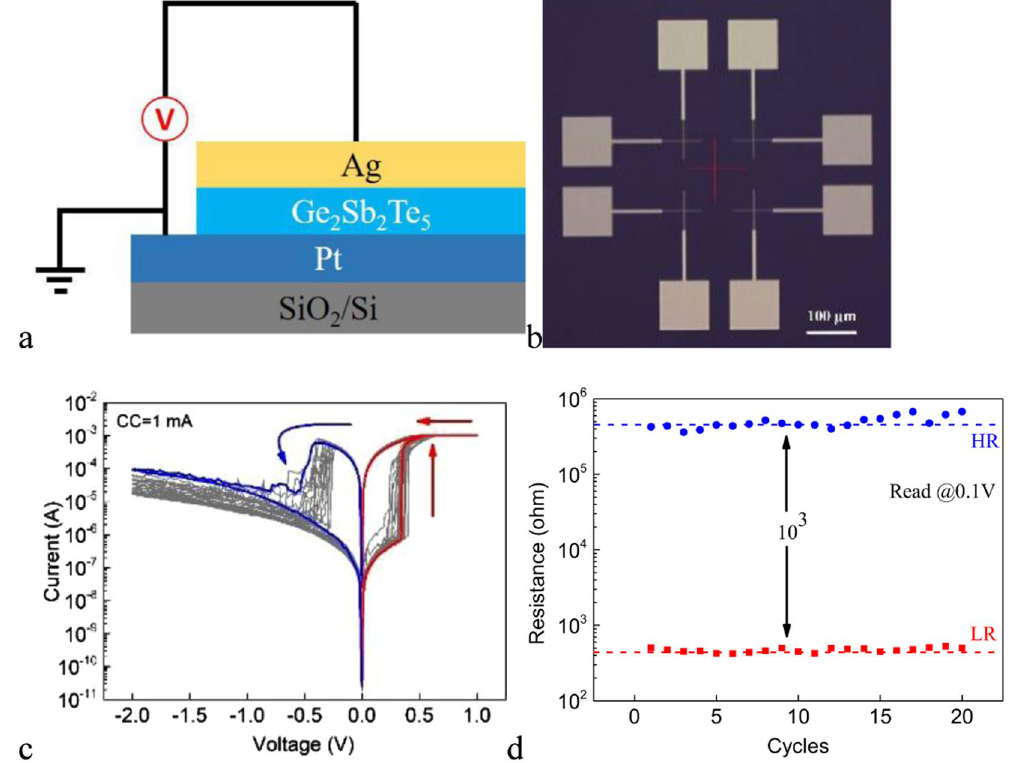
Figure 1. ( a ) The schematic structure of the Ag/Ge 2 Sb 2 Te 5 /Pt cell. ( b ) Optical image of the device with 2 × 2 μ m 2 junction area. ( c ) The DC I-V curves of 20 consecutive sweep cycles for the Ag/Ge 2 Sb 2 Te 5 /Pt cell under the SET CC of 1 mA. The positive direction in the diagrams of this work corresponds to positive voltage on the top electrode. ( d ) The LR and HR of the Ag/Ge 2 Sb 2 Te 5 /Pt cell for 20 consecutive sweep cycles. The voltage of read pulse is 100